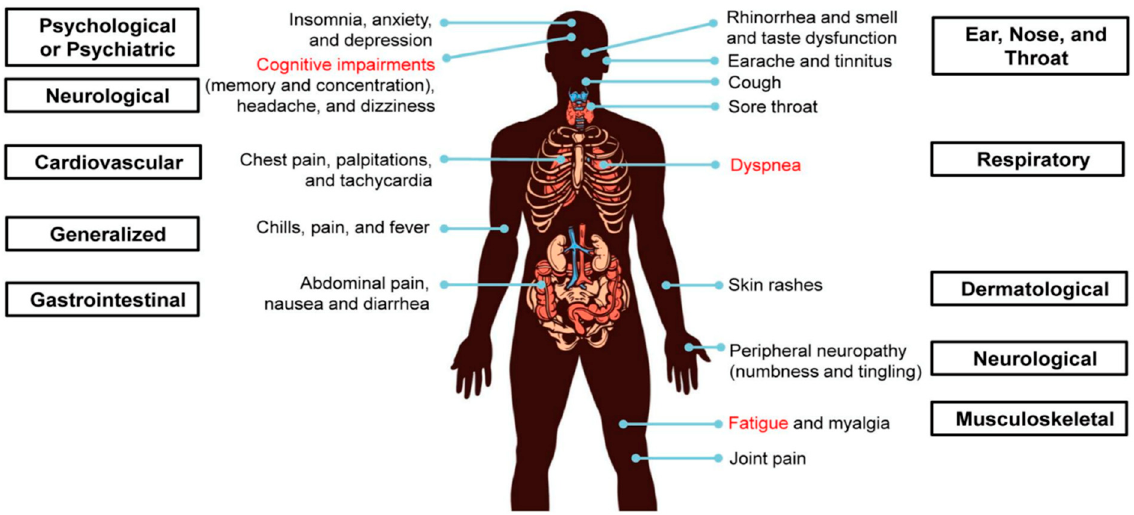
Figure 1. Symptoms of long-COVID-19. Multiple organ systems are affected, such as psychological or psychiatric (insomnia, anxiety, and depression), neurological (cognitive impairments involving memory and concentration, headache, dizziness, and peripheral neuropathy), ear, nose, and throat (rhinorrhea, smell and taste alterations, earache, tinnitus, cough, and sore throat), respiratory (dyspnea and cough), cardiovascular (chest pain, palpitations, and tachycardia), gastrointestinal (abdominal pain, nausea and diarrhea), generalized (chills, pain, and fever) and musculoskeletal (fatigue, myalgia, and joint pain). Dyspnea, fatigue, and cognitive impairments are among the most common symptoms. Reproduced from [14] under Creative Commons.